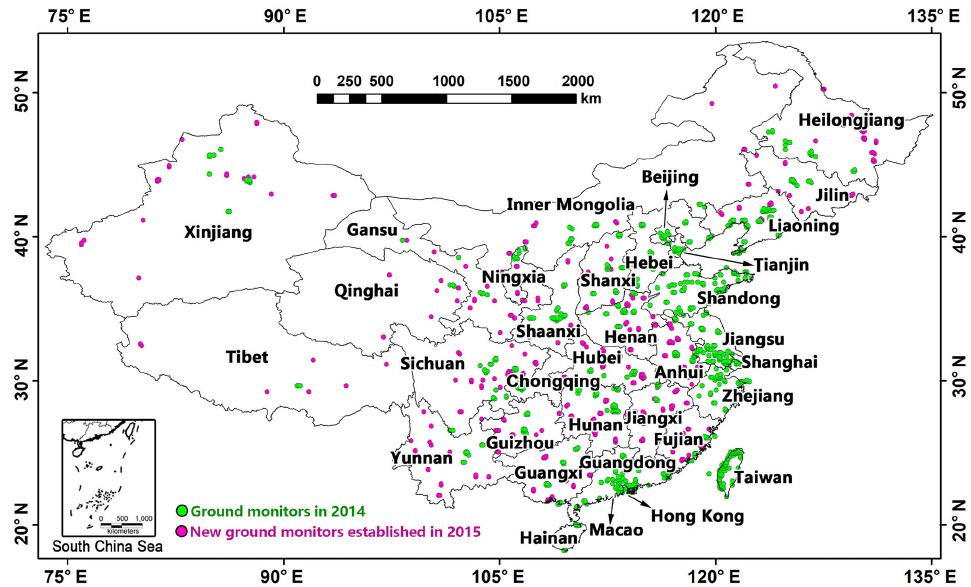
Figure 1. Spatial distributions of ground PM 2 . 5 monitors involved in model fitting and validation. Red circles denote the ground monitors in 2014. Pink circles denote new ground monitors established in